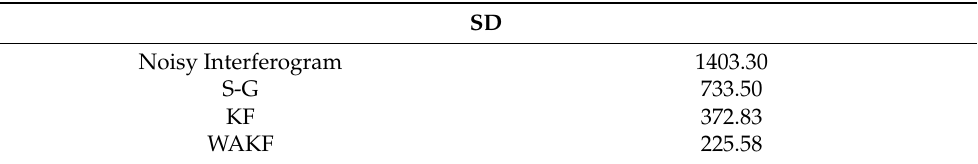
Table 1. SD for interferogram of the 747th pixel at a sampling frequency of 80 MHz.